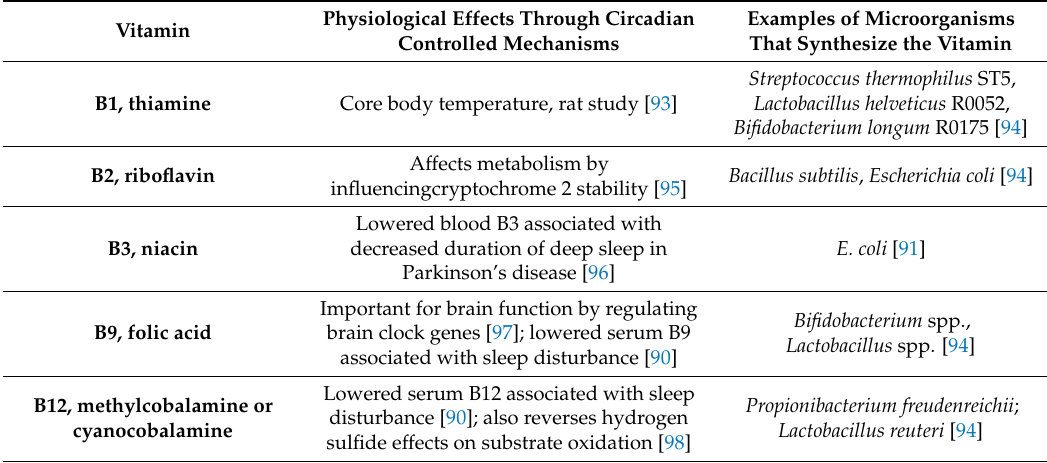
Table 3. Microbially synthesized vitamins and their physiological effects through circadian- controlled mechanisms.